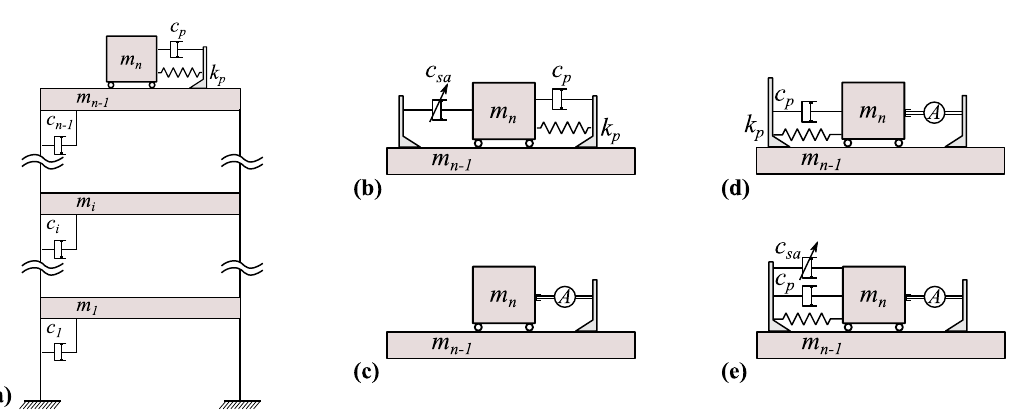
Figure 1. Structural configuration and mathematical models for ( a ) tuned mass damper (TMD); ( b ) semi ‐ active tuned mass damper (STMD); ( c ) active mass damper (AMD); ( d ) active ‐ tuned mass damper (ATMD); and ( e ) semi ‐ active hybrid mass damper (SHMD) systems.